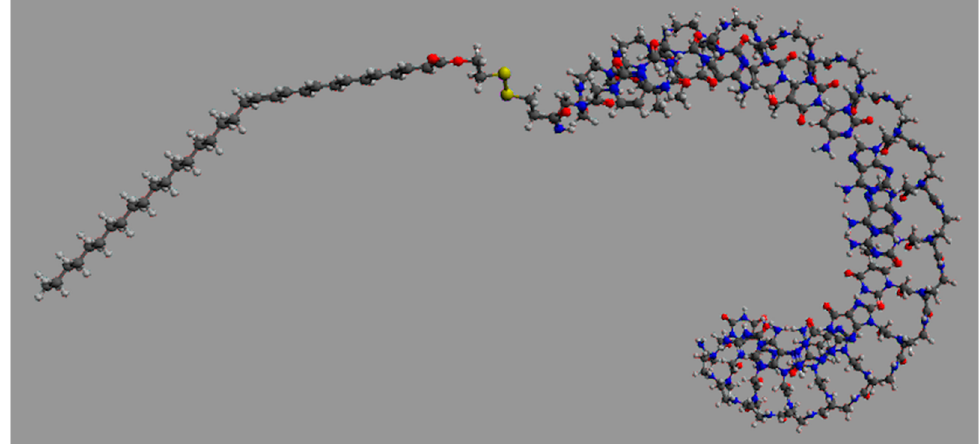
Figure 8. Graphic representation of an 18 mer miR-22-3p antagomir with a PNA (Pna) backbone coupled with C32:6 dotriacontahexaenoic fa tt y acid (5 ′ -C32-S-S-PnaC-PnaT-PnaT-PnaC-PnaT- PnaT-PnaC-PnaA-PnaA-PnaC-PnaT-PnaG-PnaG-PnaC-PnaA-PnaG-PnaC-PnaT-3 ′ ).